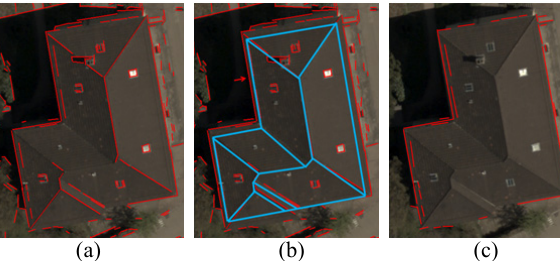
Fig.5. (a) LSD result with red lines. (b) blue lines indicate back-projected lines of 3D straight skeleton. (c) the filter result of chosen candidate lines In fact, 2D line segments derived from multi-view images are different with each other, making it possible to combine them to form the complete candidate lines. As in figure 6, the filtered line segments differ in multiple oblique images and supplement each other. Based on the complete candidate lines, each boundary line is assigned with several corresponding candidate lines.